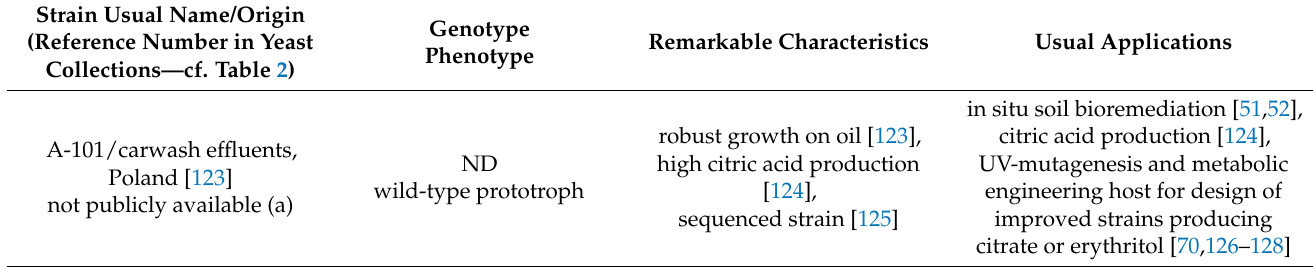
Table 1. Selection of remarkable Yarrowia lipolytica wild-type or engineered (GM) strains of biotechnological interest deposited in public yeast collections (haploid, unless